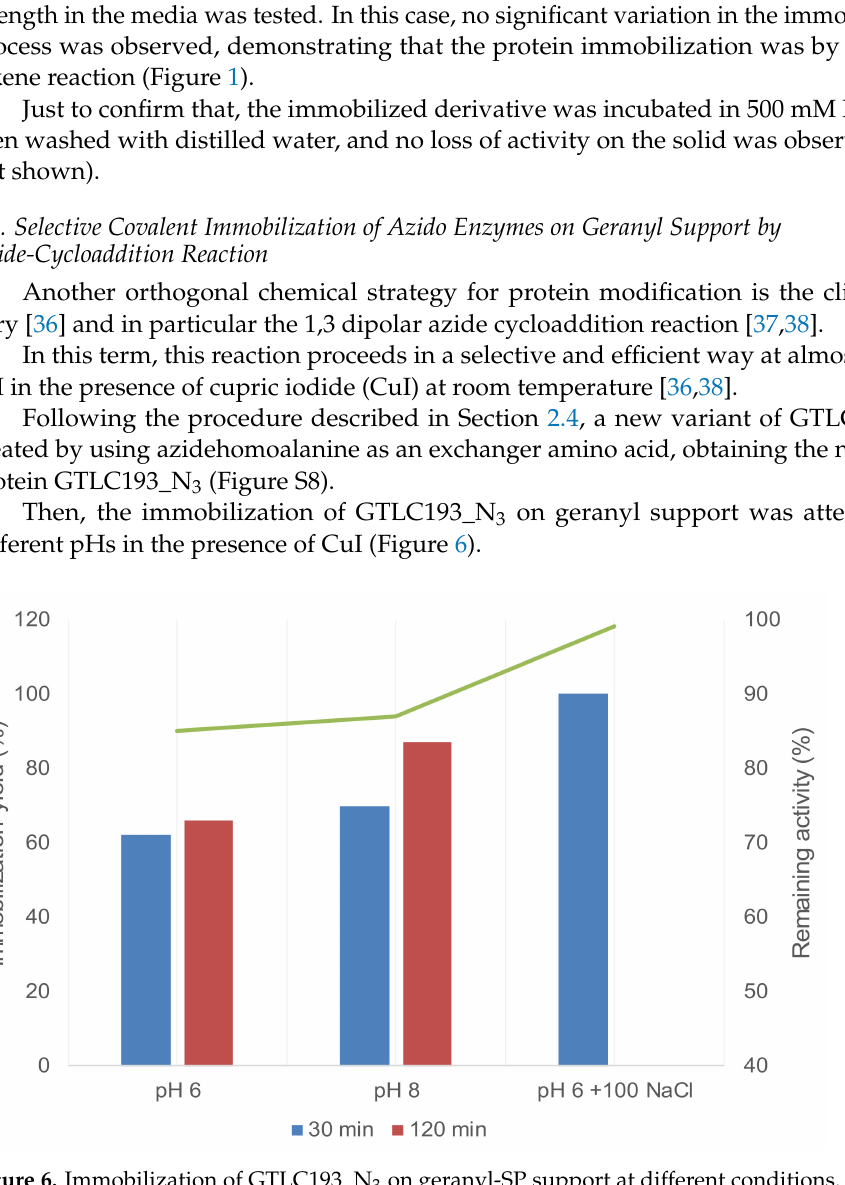
Figure 6. Immobilization of GTLC193_N 3 on geranyl-SP support at different conditions. The best results were obtained at pH 8 after 2 h incubation with 87% immobilization, whereas at pH 6, the value was around 70% (Figure 6). In both cases, the